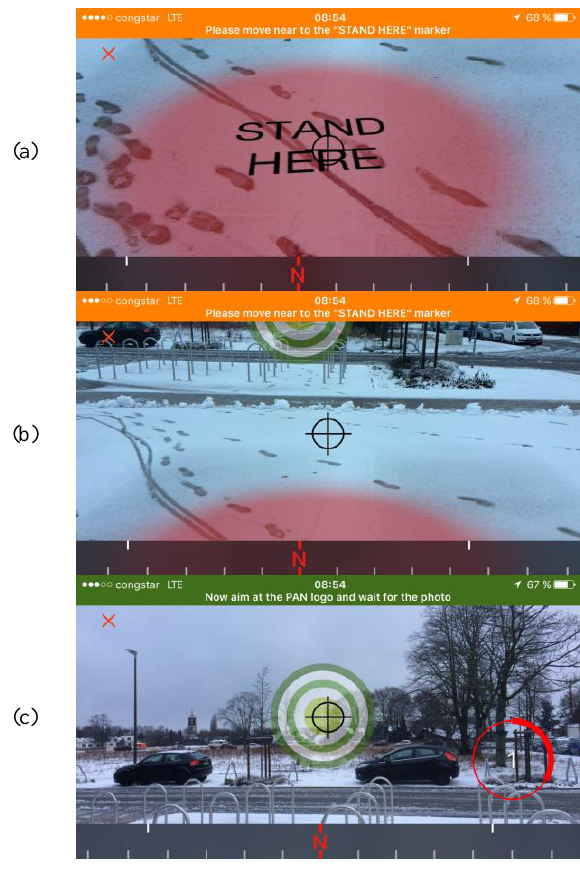
Figure 3. Augmented guiding to the virtual photo location (a), target (b) and automatic photo triggering